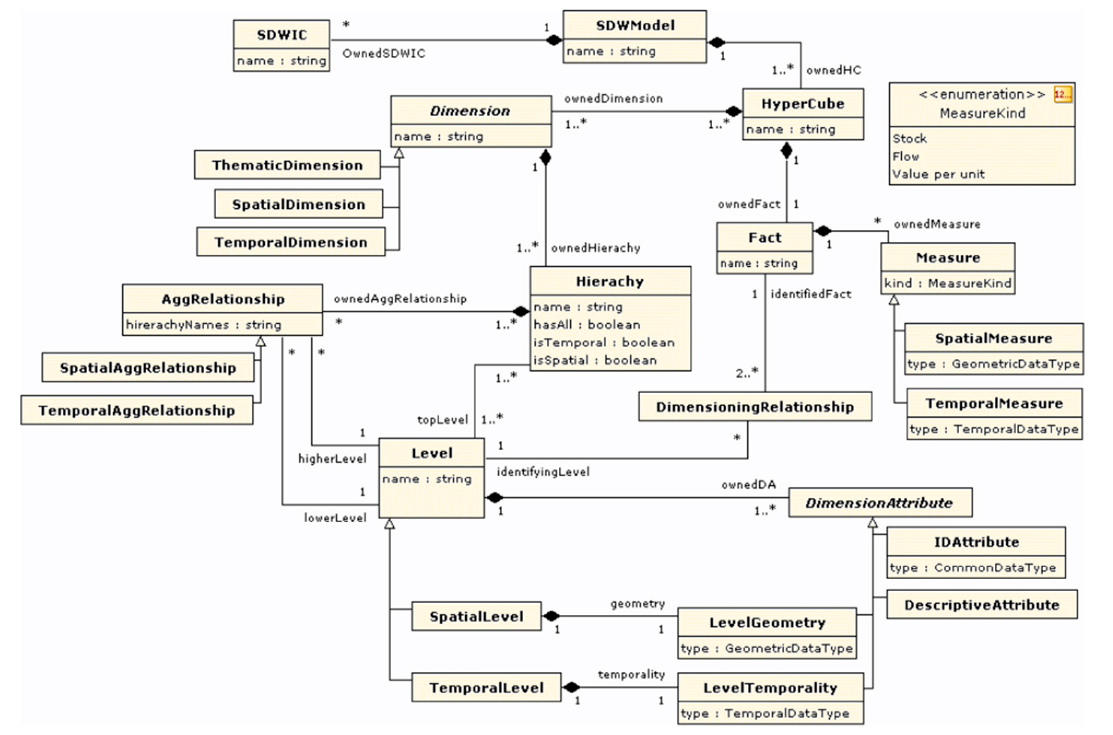
Figure 2. A unified modeling language (UML) data cube metamodel example [41]. Asterisk means “n” according to UML convention.